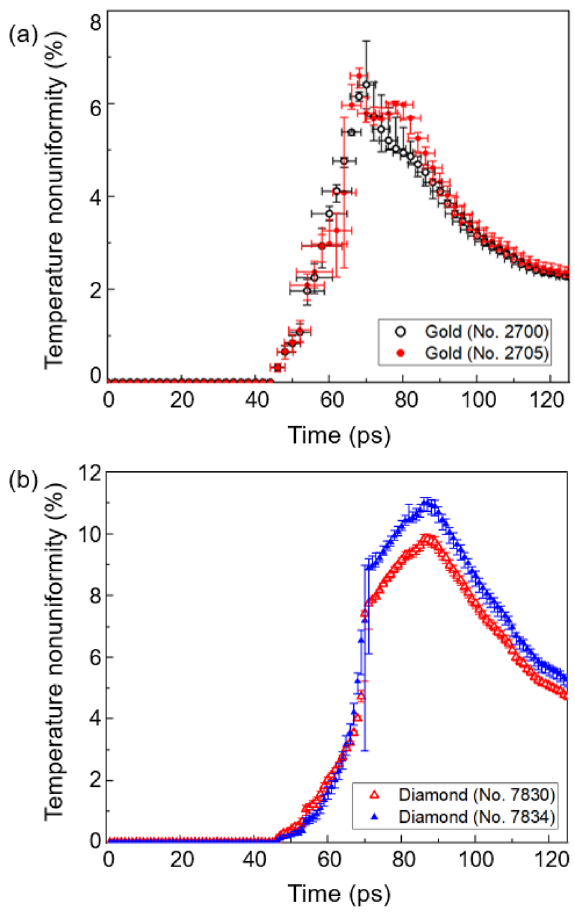
Figure 5. ( a ) Temperature nonuniformity of the gold sample is shown as a function of time from 0 to 125 ps. ( b ) Temperature nonuniformity of the diamond sample is shown as a function of time from 0 to 125